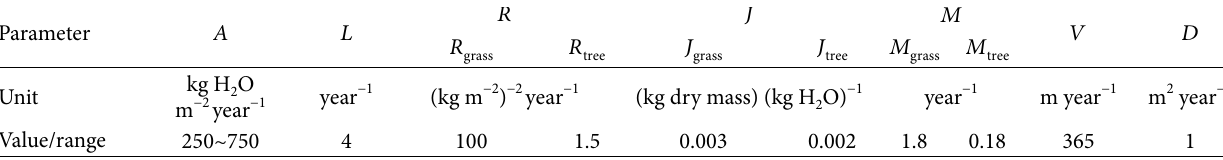
Table 1: Parameter values/range used in Klausmeier [13].